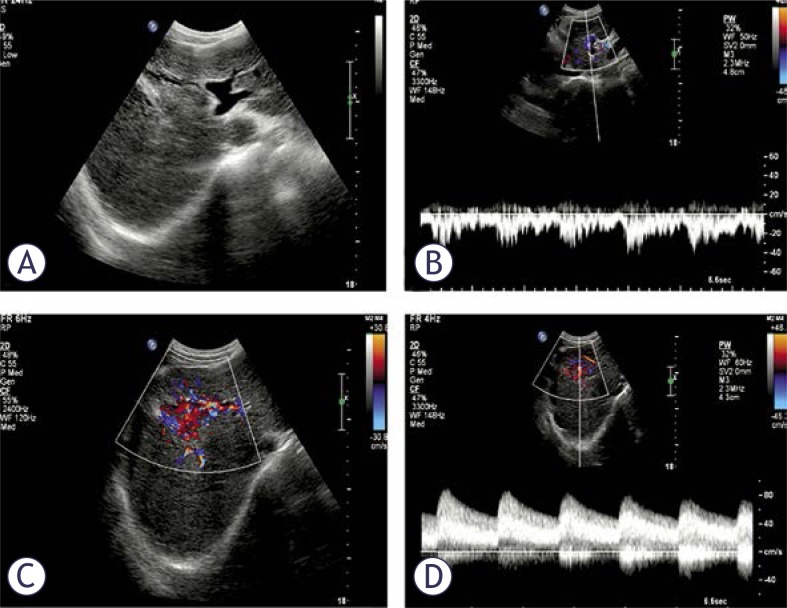
US findings for a typical intrahepatic APF. (A) The dilated draining left portal vein. (B) The arterial-like velocity tracing of the draining portal vein with a continuous hepatofugal flow. (C) The turbulent area of APF. (D) The velocity tracing of a feeding artery with fast flow and a low RI.